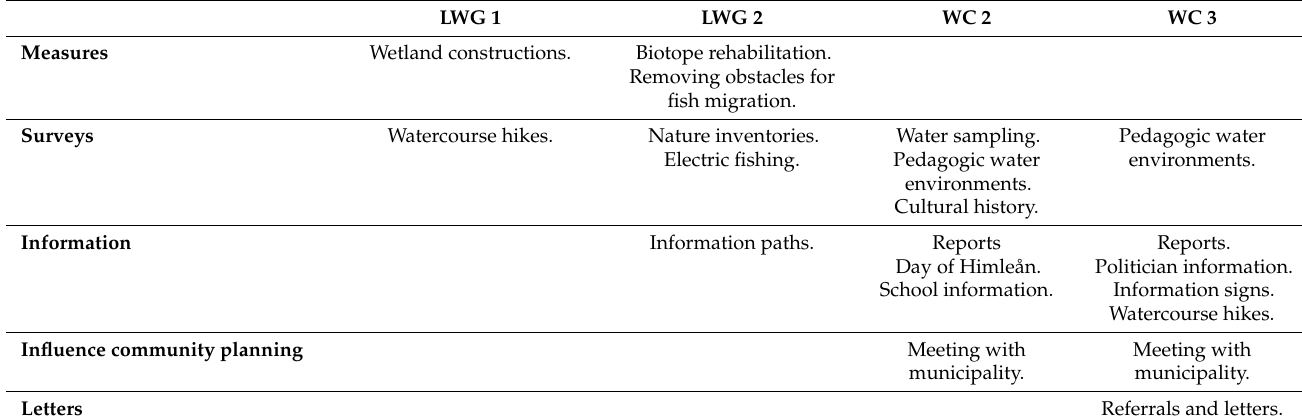
Table 3. The main focus of the pilot projects divided into different categories of activities. The smaller local water groups were more focused on measures than the water councils which were more focused on information. LWG 1 WC 3 Measures Wetland constructions. Biotope rehabilitation. Removing obstacles for fish migration. Surveys Watercourse hikes. Nature inventories. Electric fishing. environments. Cultural history. Information Information